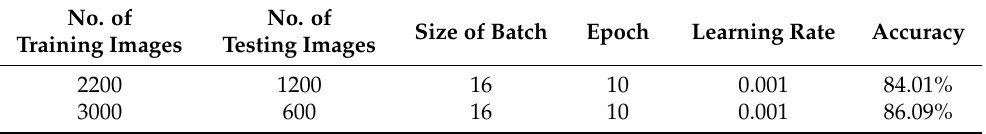
Table 5. Comparison between same batch size and different no of training and testing images.